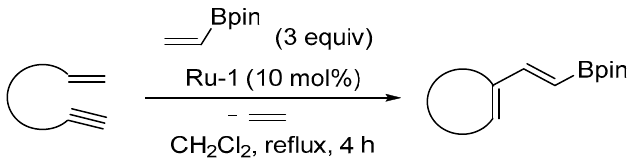
Figure 2. Scope of products obtained by one-pot RCM/oxidation/1,3-dipolar cycloaddition proto-